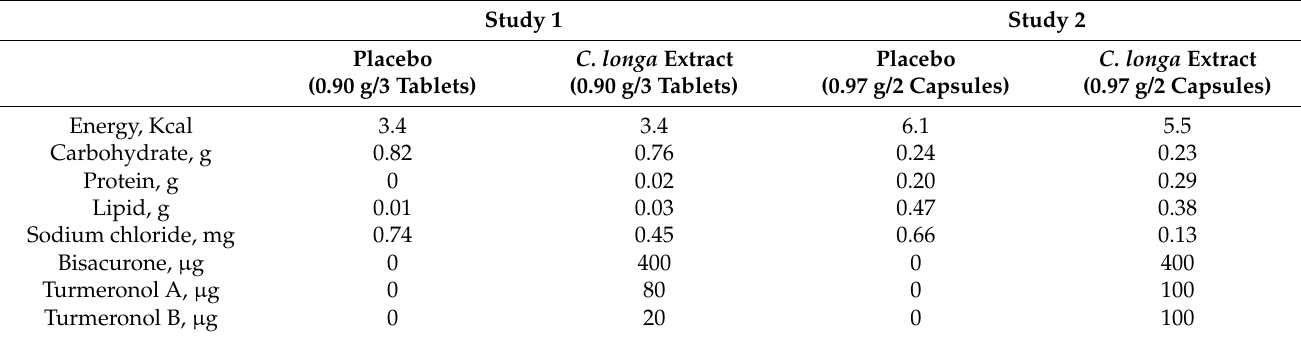
Table 1. Composition of test